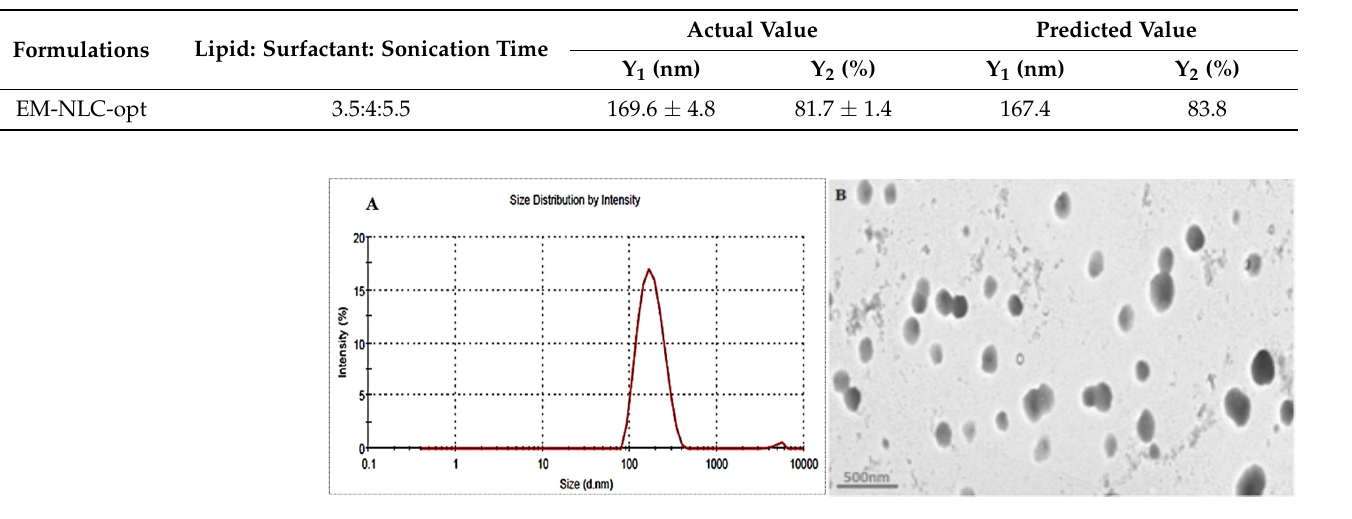
Figure 4. ( A ). Particle size and ( B ). TEM image of EM-NLCs-opt. Table 4. Point prediction optimization by central composite design.